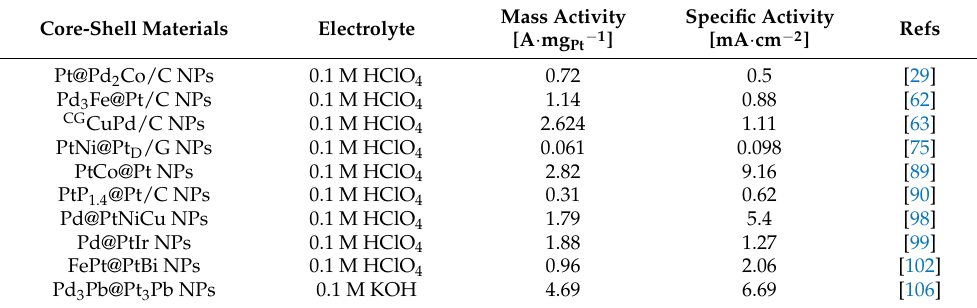
Table 1. Summary of ORR activities of core–shell catalysts (measured at 0.9 V). Core-Shell